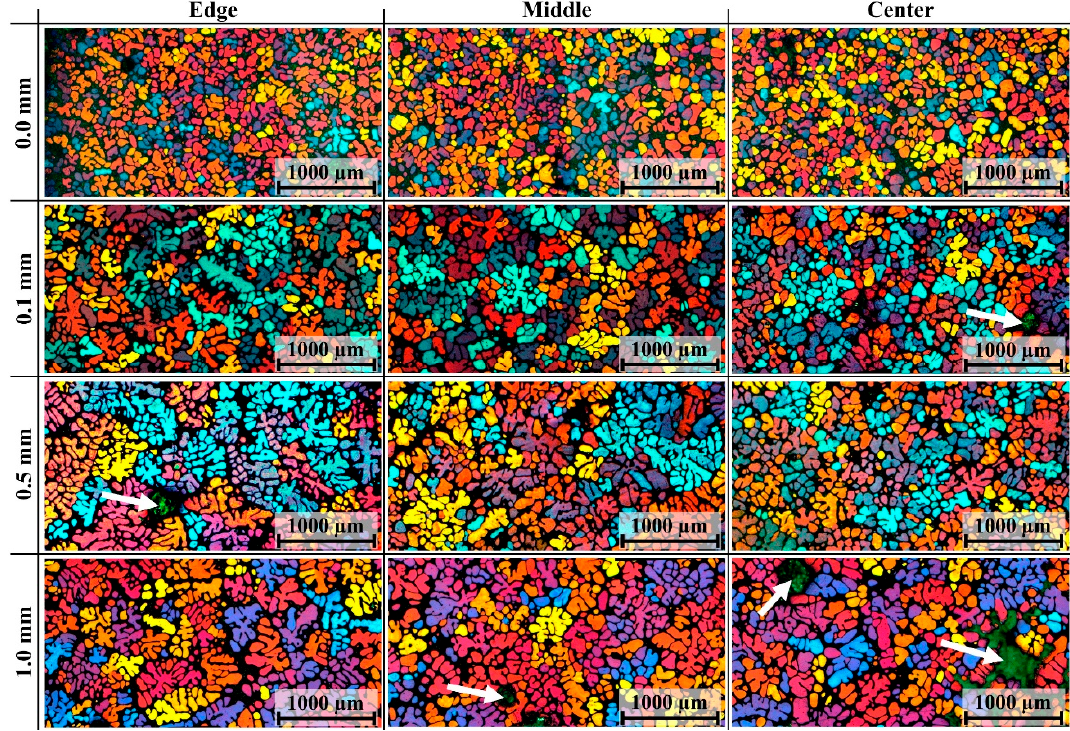
Figure 9. Representative micrographs of quenched slug under different thicknesses of boron nitride coating. The bottle green region marked by white arrows is porosity which formed during the quench process. (The color information of this figure is shown in the web or color print version of this paper.)